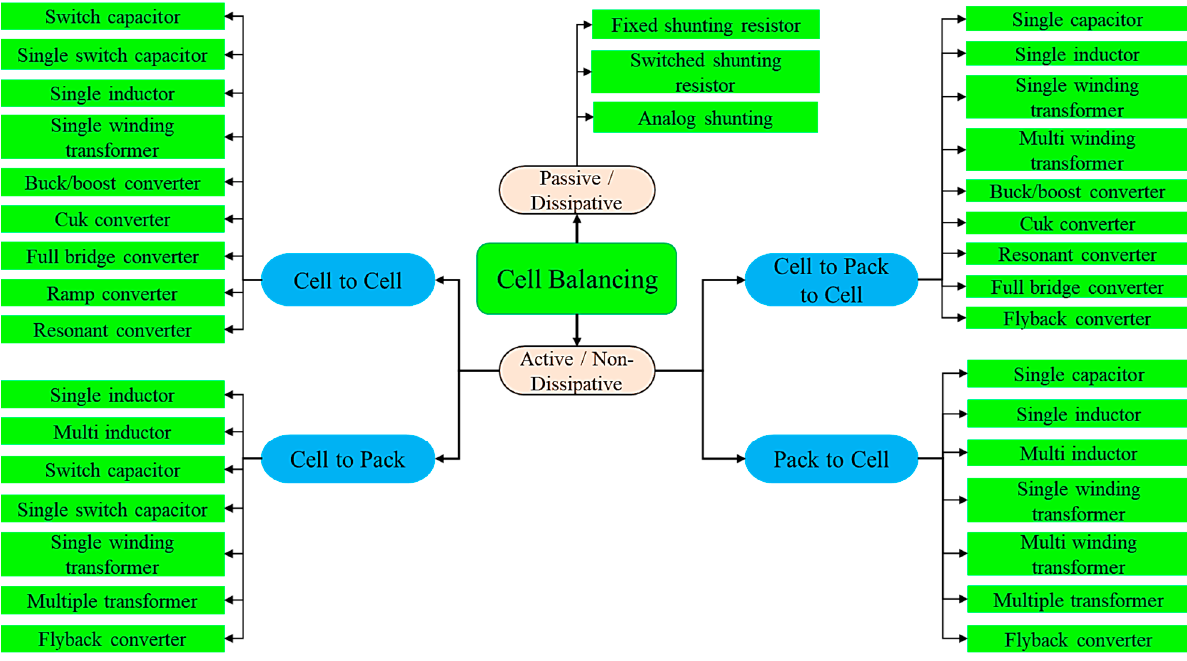
Figure 6. Cell balancing topology.